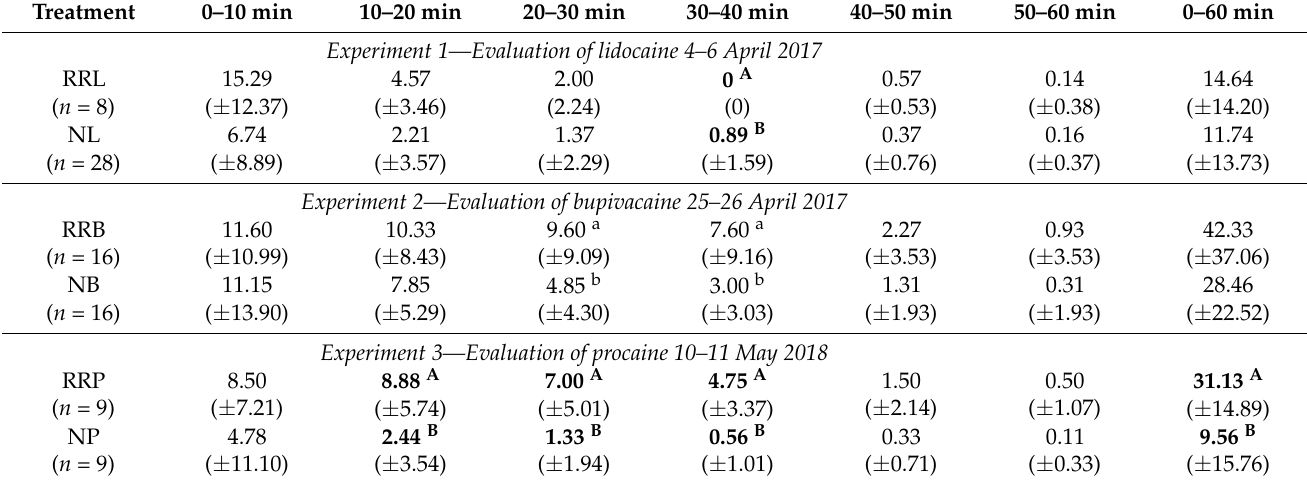
Table 7. Mean ( ± standard deviation) count of restlessness expressed by female lambs. Within each experiment, means within a column with differing uppercase superscripts (A, B) differ significantly ( p < 0.05), while differing lowercase superscripts (a, b) indicate a tendency to differ (0.1 > p > 0.05). RRL ring only, no local anesthetic; NL ring applied with lidocaine administered using the Numnuts ® tool; RRB ring only, no local anesthetic; NB ring applied with bupivacaine administered using the Numnuts ® tool; RRP ring only, no local anesthetic; NP ring applied with procaine administered using the Numnuts ®